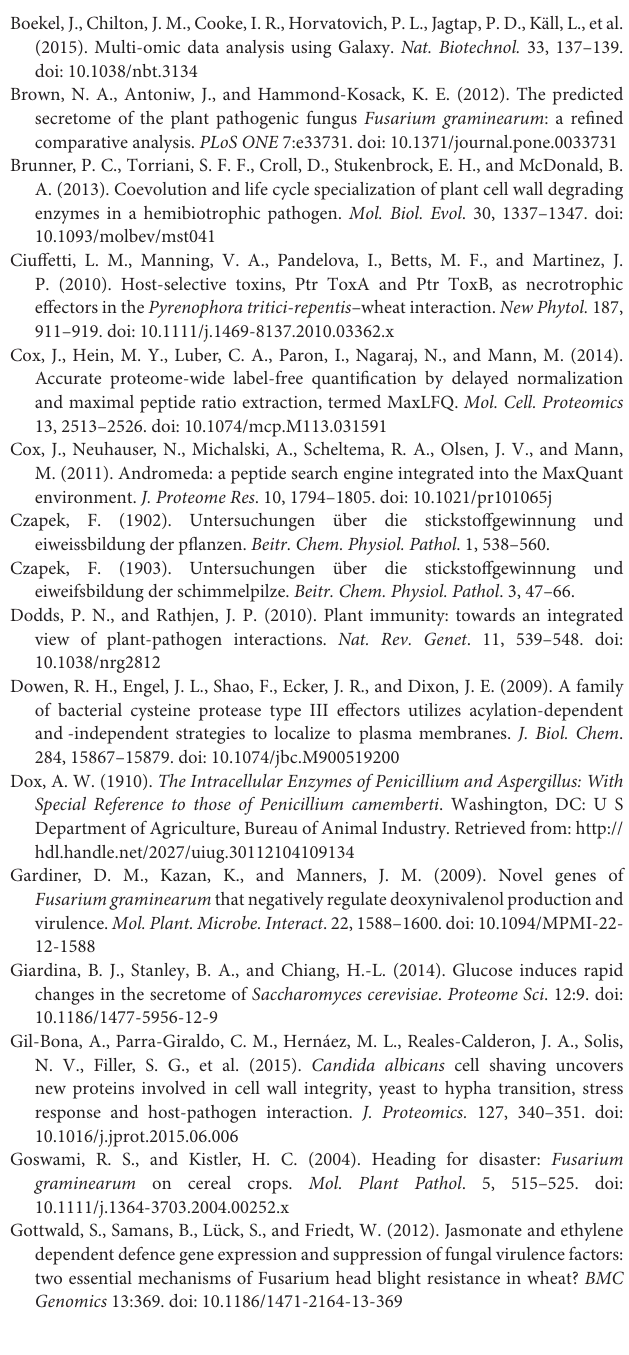
Table S1 | Peptidase microarray data.